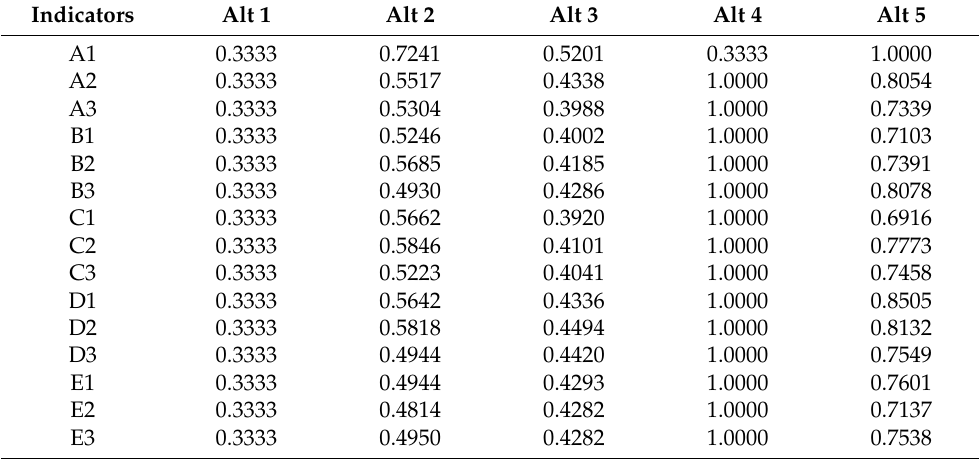
Table 16. Grey rational